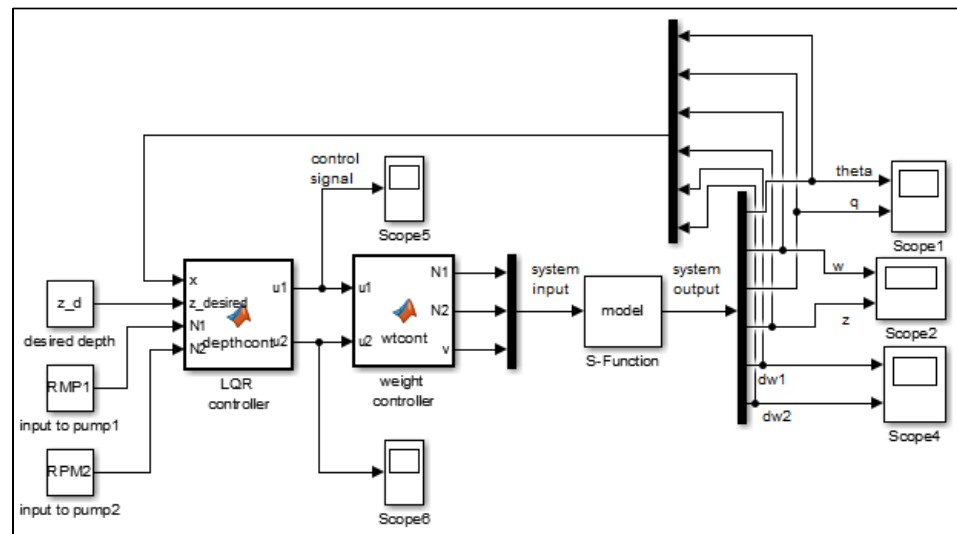
Figure 11. Simulink structure of the Linear Quadratic Controller (LQR) controller used in our CSM.